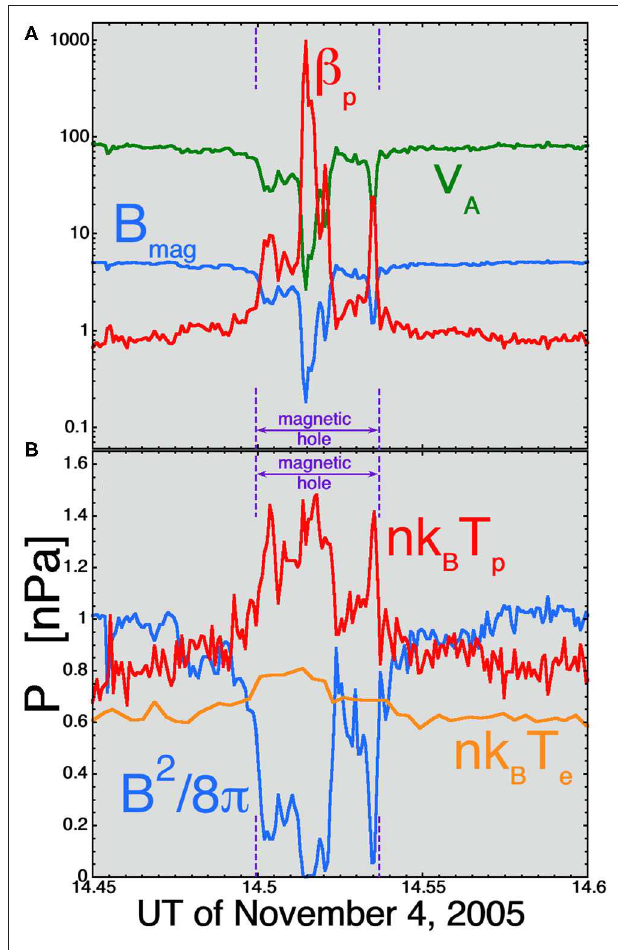
FIGURE 3 | An example of a magnetic hole (denoted in purple) during Flattop 15. Nine minutes of WIND spacecraft data [plasma properties in panel (A) and pressures in panel (B) ] are plotted, and the duration of the magnetic hole as seen by WIND was